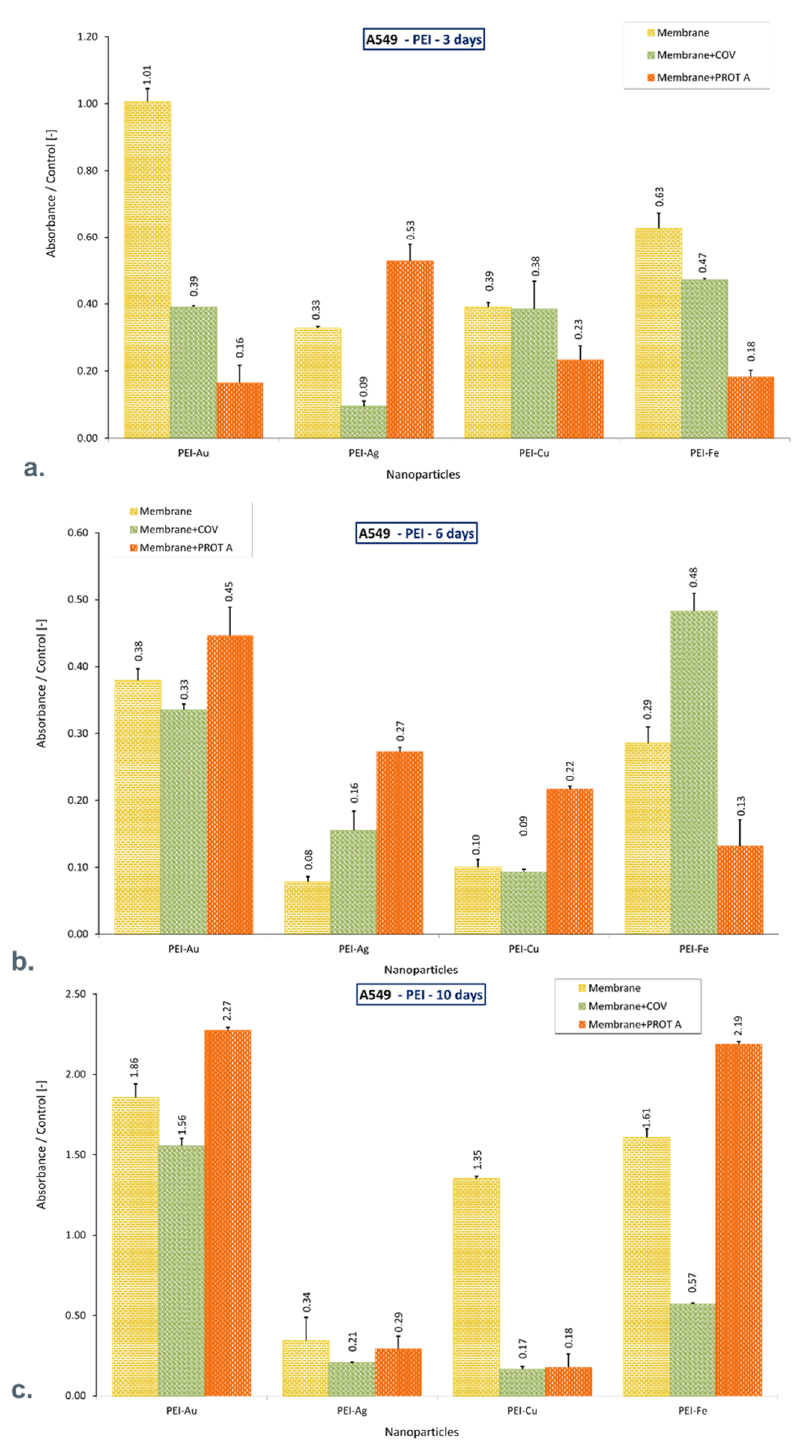
Figure 4. The ratio of the mitochondrial activity of A549 immobilized on membranes represented by formazan production expressed by absorbance to the control after ( a ). 3-day culture, ( b ). 6-day culture, ( c ). 10-day culture. The values are presented as mean ± SD. Key to the symbols: PEI-Ag: polyethyleneimine membrane with AgNPs incorporated; PEI-Au: polyethyleneimine membrane with AuNPs incorporated; PEI-Cu: polyethyleneimine membrane with CuNPs incorporated, PEI- Fe: polyethyleneimine membrane with FeNPs incorporated. Membrane—the membrane without adsorbed COV or PROT A; Membrane + COV—membrane with adsorbed COV; Membrane + PROT A—membrane with adsorbed Protein A.